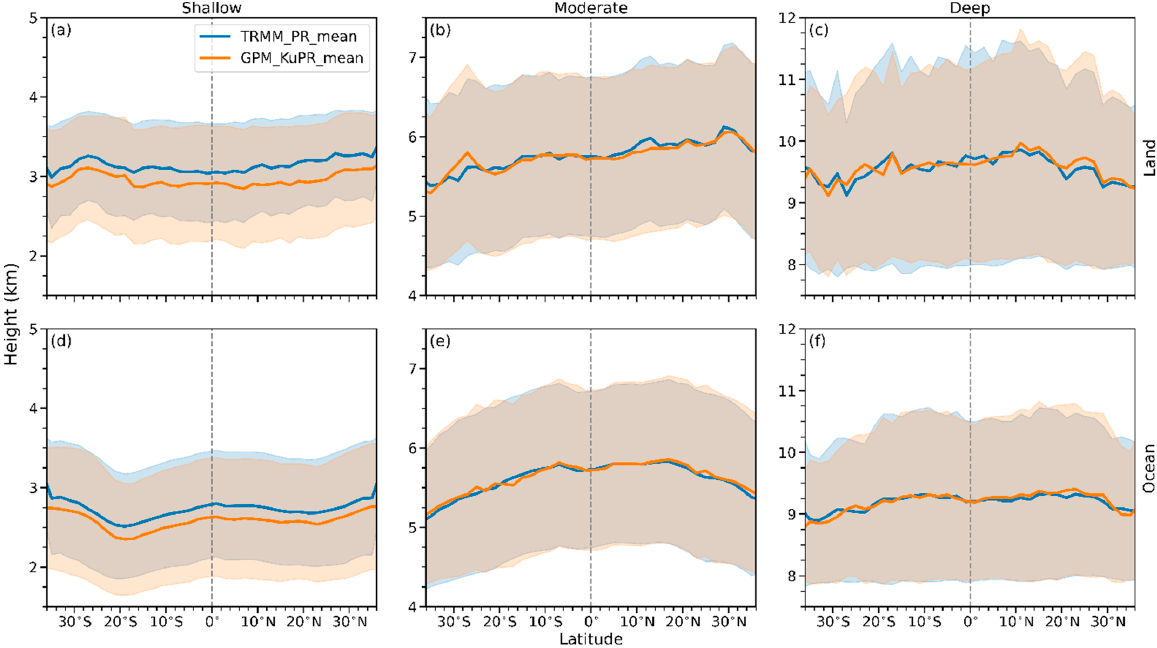
Figure 9. Same as Figure 8, but for shallow (Topht20 < 4 km, first column), moderate (4 km ≤ Topht20 < 8 km, second column), and deep (Topht20 ≥ 8 km, third column) convection events over ( a – c ) land and ( d – f )